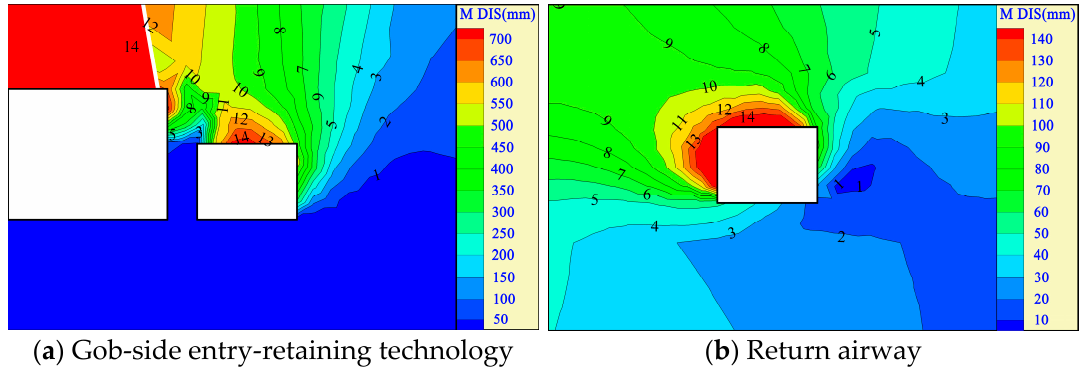
Figure 15. Roadway deformations after roof cutting.